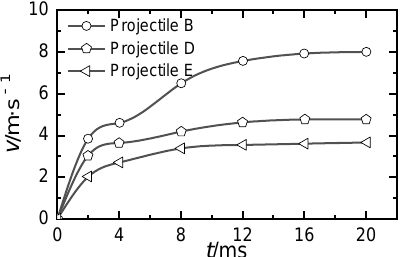
Figure 10. Gas-curtain displacement under different groove numbers.